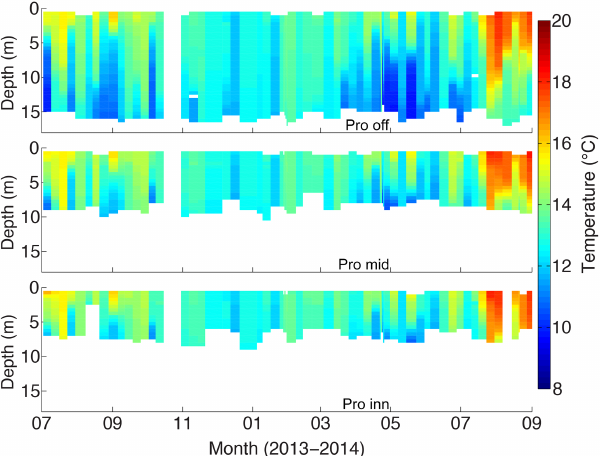
Figure 3. Depth-resolved temperature profiles along the protected transect throughout the 14-month time series. White spaces, includ- ing October 2013 and August 2014, are missing data due to the CTD not recording or poor data removed during quality